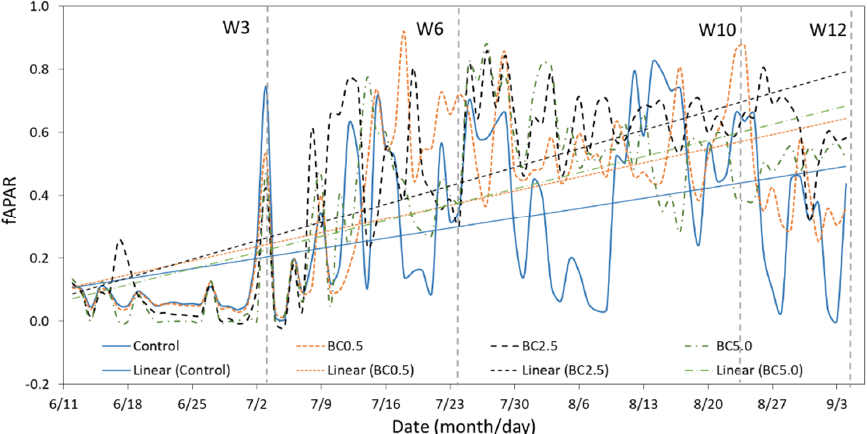
Figure 5. Average midday values of fraction of absorbed photosynthetically active radiation (fAPAR) data for the different treatments. W3, W6, W10, and W12 represents the time in weeks when additional plant measurements occurred.